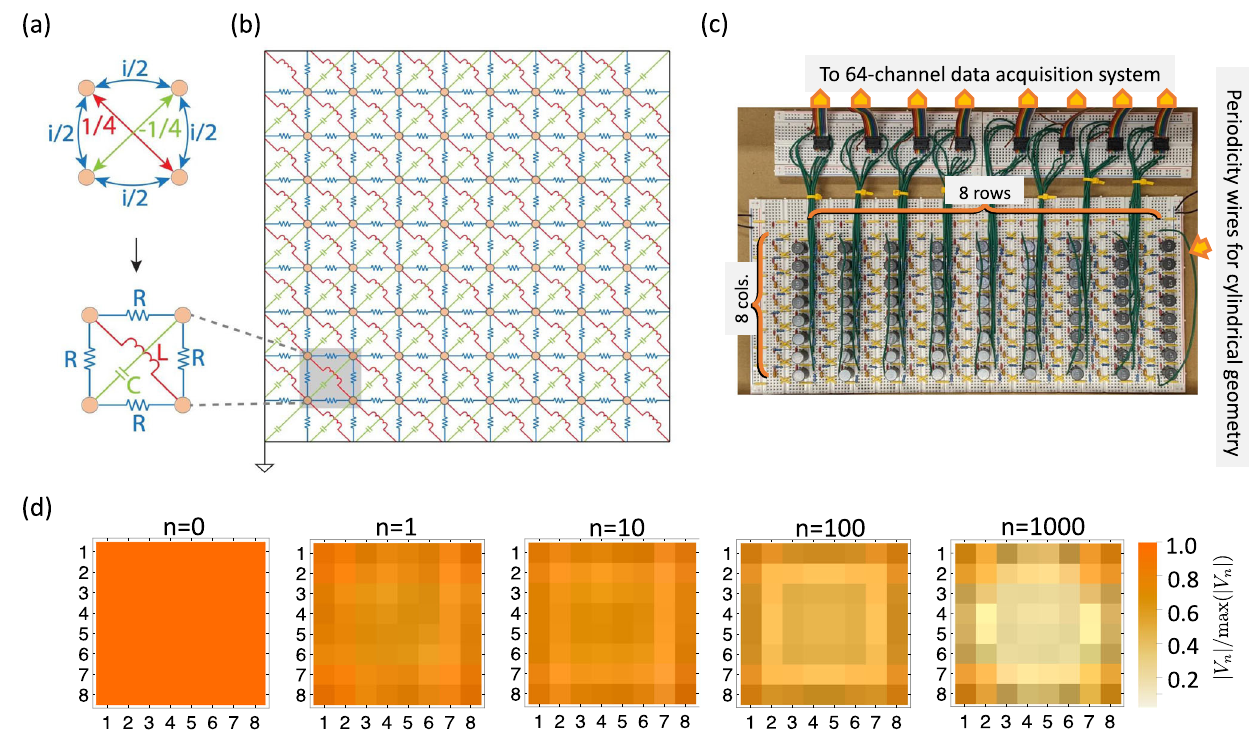
c Photograph of the assembled circuit board, of which each row/column corre- sponds to that in b directly. Each node is wired to a 64-channel data acquisition system. d Simulation showcasing the dynamical rank-2 behavior in the 64-node : 1 =1 : 1 : 2 for a circuitnetwork,where n labelsthestepand V n (indicatedbythecolorscaleateach L R node) is the input voltage in n -th